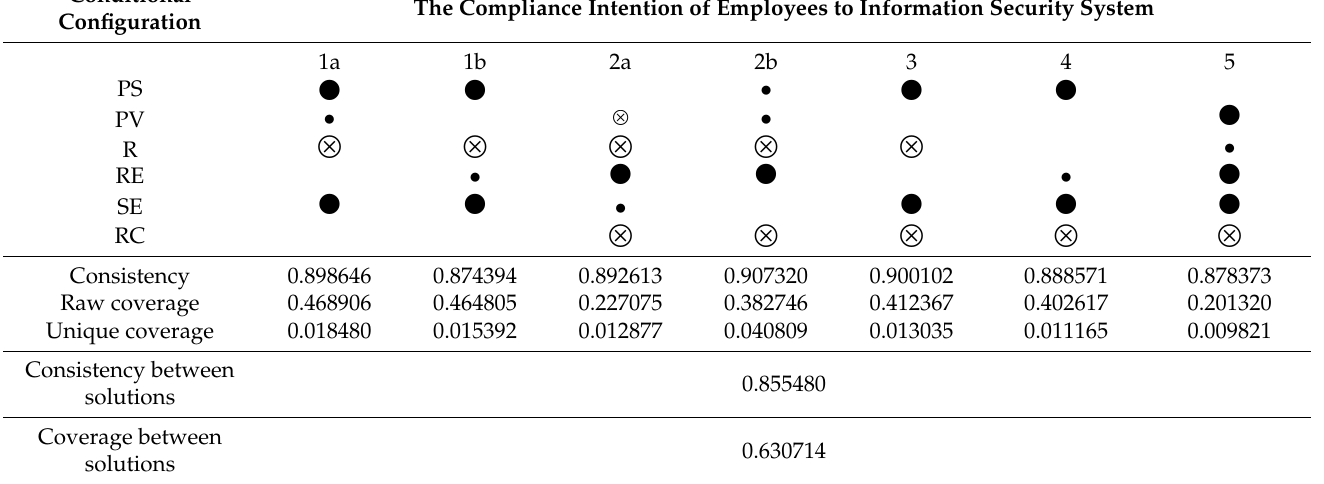
with the information security system (see Table 7). Table 7. Configuration results of employees ’ intention to comply with the information security sys- Table 7. Configuration results of employees ’ intention to comply with the information security sys- Table 7. Configuration results of employees ’ intention to comply with the information security sys- Table 7. Configuration results of employees ’ intention to comply with the information security sys- Table 7. Configuration results of employees ’ intention to comply with the information security sys- tem. tem. tem. tem. tem. Table 7. Configuration results of employees ’ intention to comply with the information security sys- Table 7. Configuration results of employees ’ intention to comply with the information security sys- Table 7. Configuration results of employees ’ intention to comply with the information security sys- Table 7. Configuration results of employees’ intention to comply with the information security system. Table 7. Configuration results of employees ’ intention to comply with the information security sys- tem. tem. tem. tem. Table 7. Configuration results of employees ’ intention to comply with the information security sys- Table 7. Configuration results of employees ’ intention to comply with the information security sys- tem. tem. Table 7. Configuration results of employees ’ intention to comply with the information security sys- Table 7. Configuration results of employees ’ intention to comply with the information security sys- Table 7. Configuration results of employees ’ intention to comply with the information security sys- Table 7. Configuration results of employees ’ intention to comply with the information security sys- Table 7. Configuration results of employees ’ intention to comply with the information security sys- tem. tem. tem. tem. Table 7. Configuration results of employees ’ intention to comply with the information security sys- Table 7. Configuration results of employees ’ intention to comply with the information security sys- Table 7. Configuration results of employees ’ intention to comply with the information security sys- tem. tem. tem. Table 7. Configuration results of employees ’ intention to comply with the information security sys- Table 7. Configuration results of employees ’ intention to comply with the information security sys- Table 7. Configuration results of employees ’ intention to comply with the information security sys- Table 7. Configuration results of employees ’ intention to comply with the information security sys- Table 7. Configuration results of employees ’ intention to comply with the information security sys- tem. tem. tem. tem. tem.